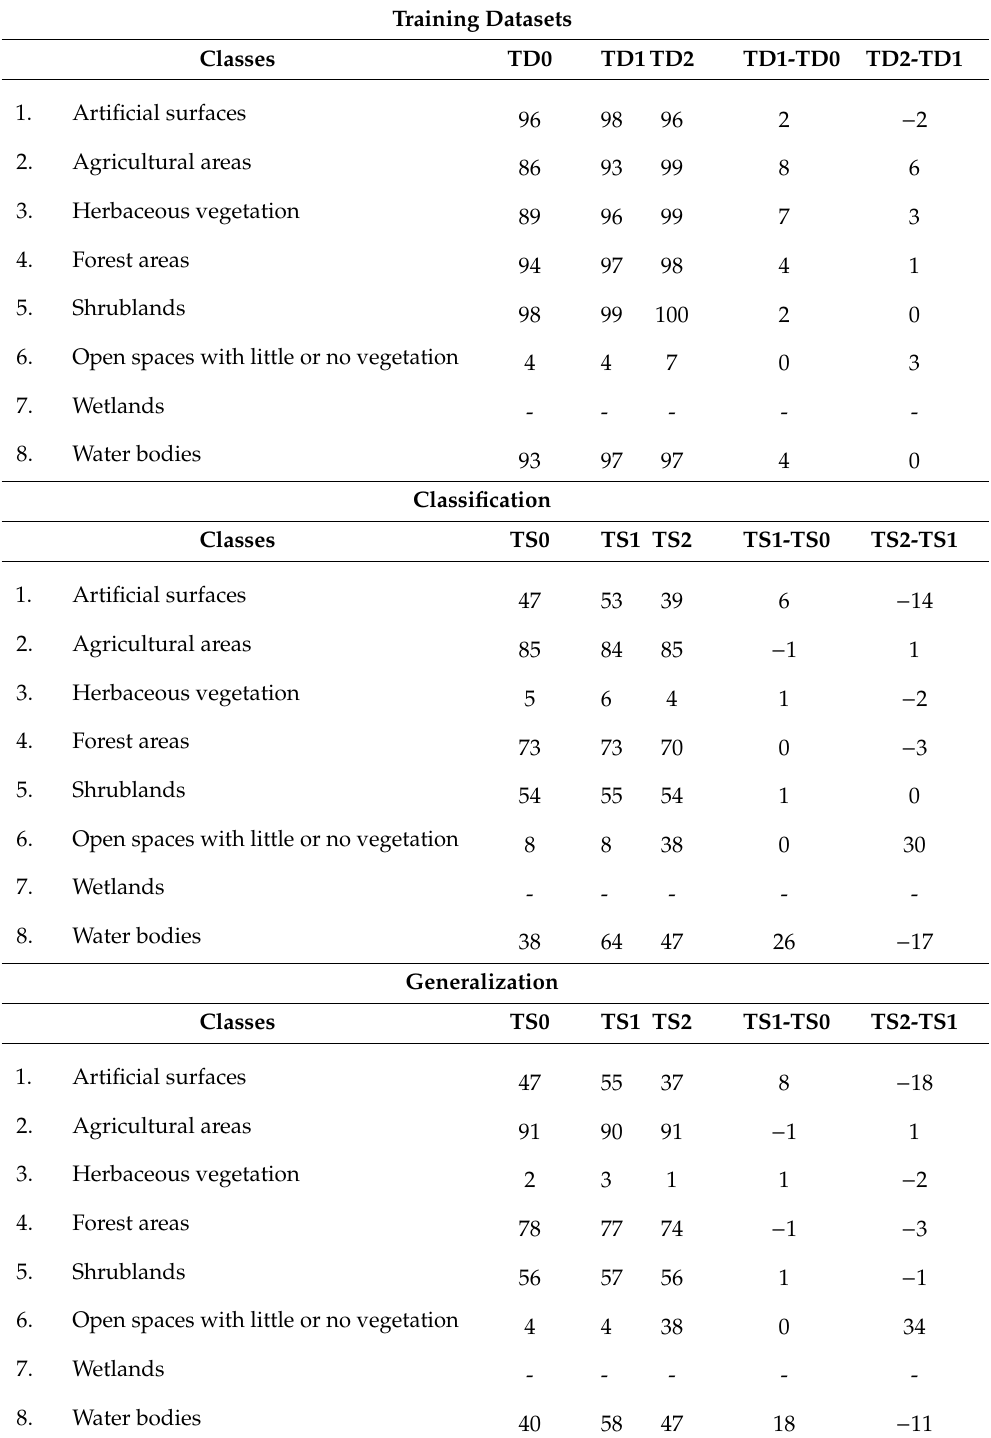
Table 12. Producer’s Accuracy per class (%) (equal to 100 minus the omission errors) for Study area B of the training datasets TD0, TD1 and TD2 and of the maps shown in Figure 12 resulting from the classification with TS0, TS1 and TS2. The reference data used are the maps derived from the COS 2018 with the nomenclature